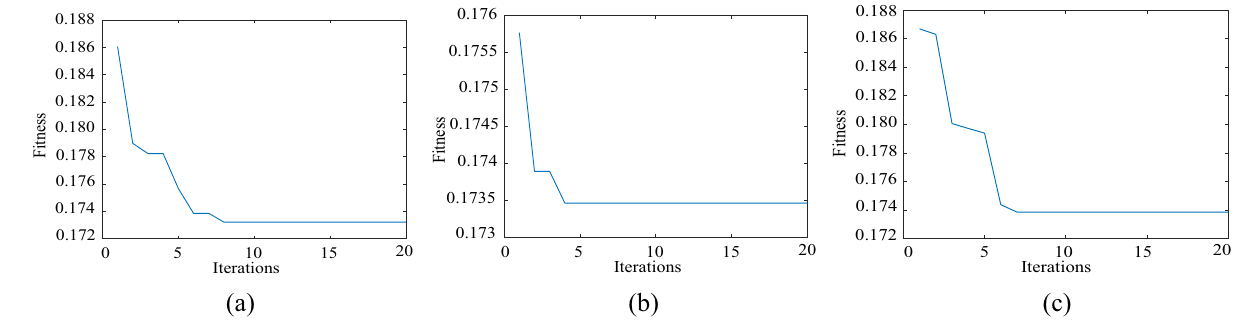
Figure 7. The iterative process of the proposed algorithm under 5 dB. ( a ) TS-WOA-VMD. ( b ) WOA-VMD. ( c )